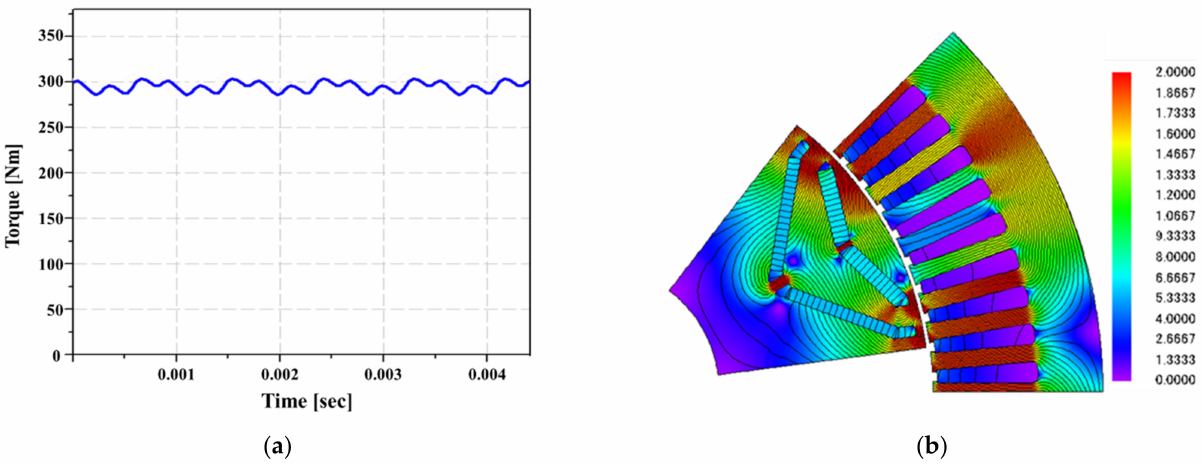
Figure 12. Design result of the base model in load condition: ( a ) torque waveform; ( b ) magnetic flux density and flux line